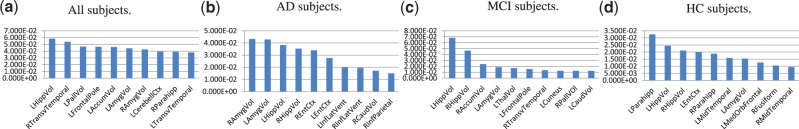
Top 10 FreeSurfer markers identified for rs423958-APOE.